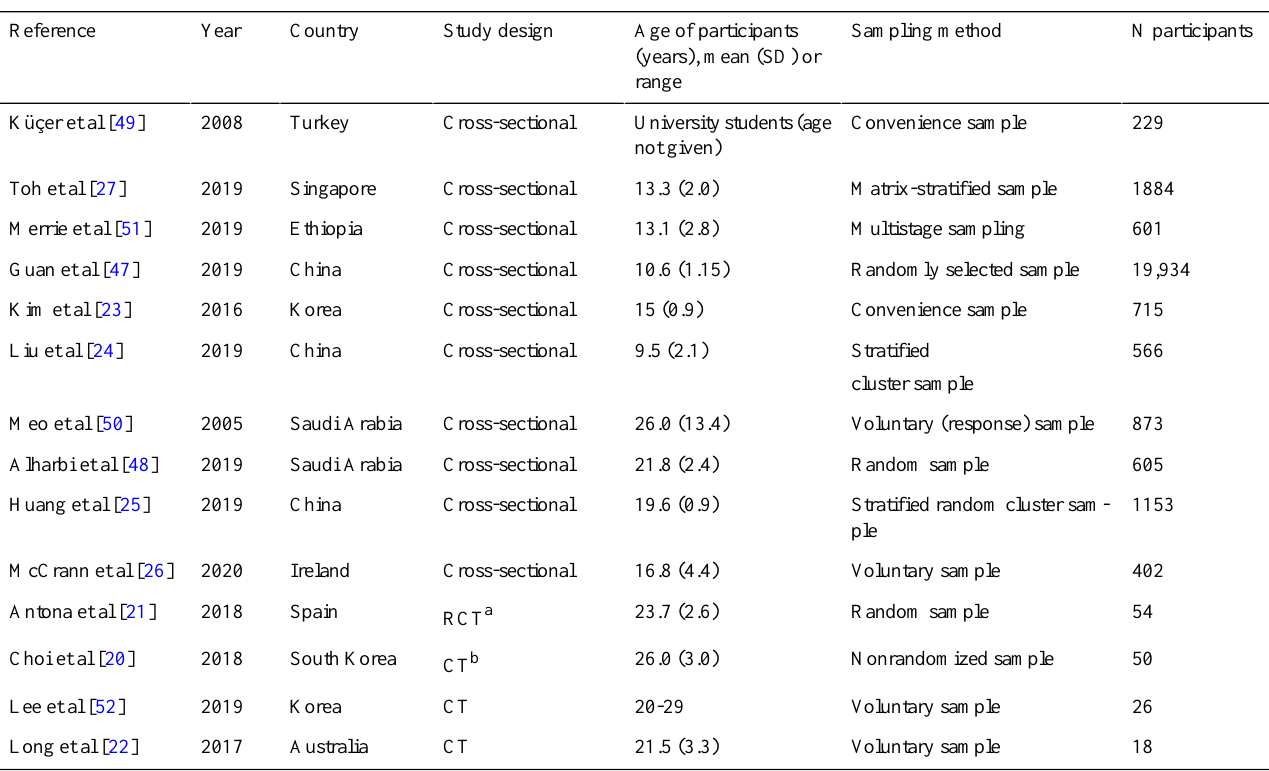
Table 1. General characteristics of the included studies.